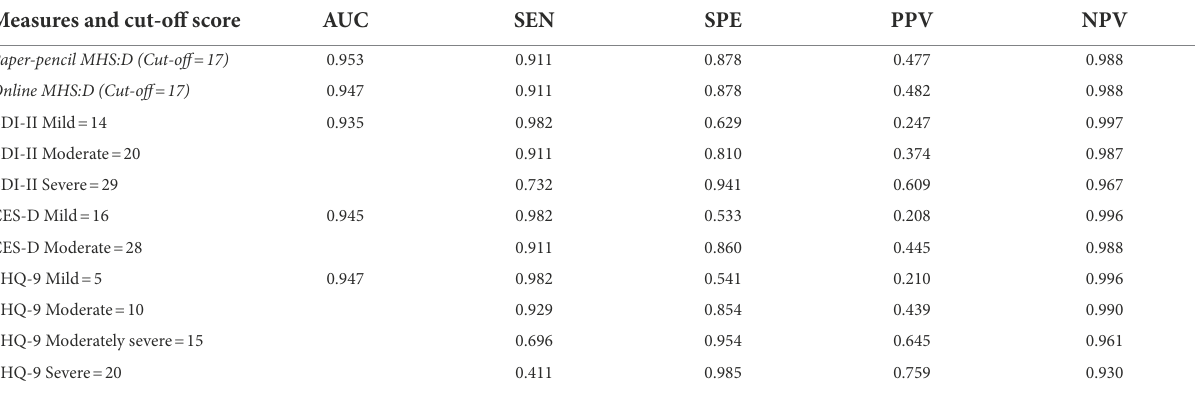
TABLE 7 Results of ROC analyses for the MDD.